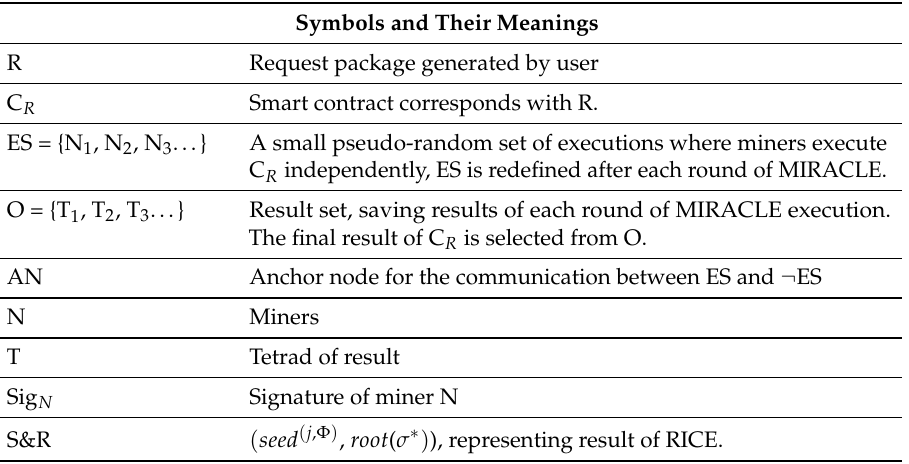
Table 2. Symbols and meanings in the protocol. Symbols and Their